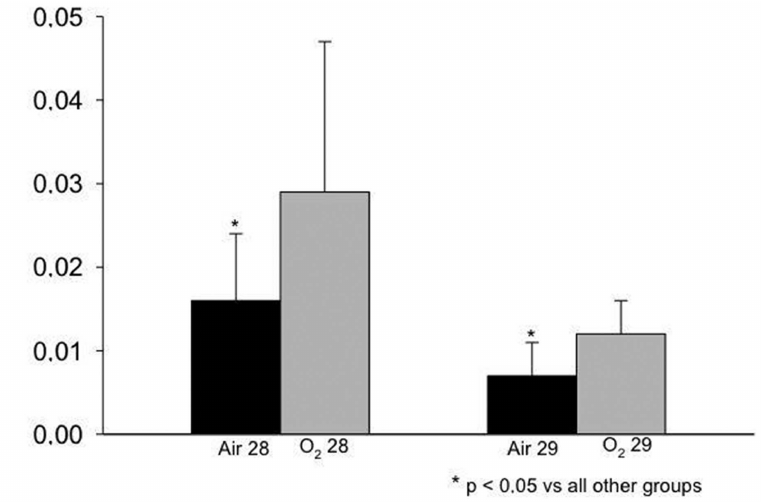
Figure 3. Collagen fibers proportion observed in the study groups. A higher proportion of collagen fibers were observed in both oxygen exposed groups compared with room air at the same gestational age (p , 0.05)